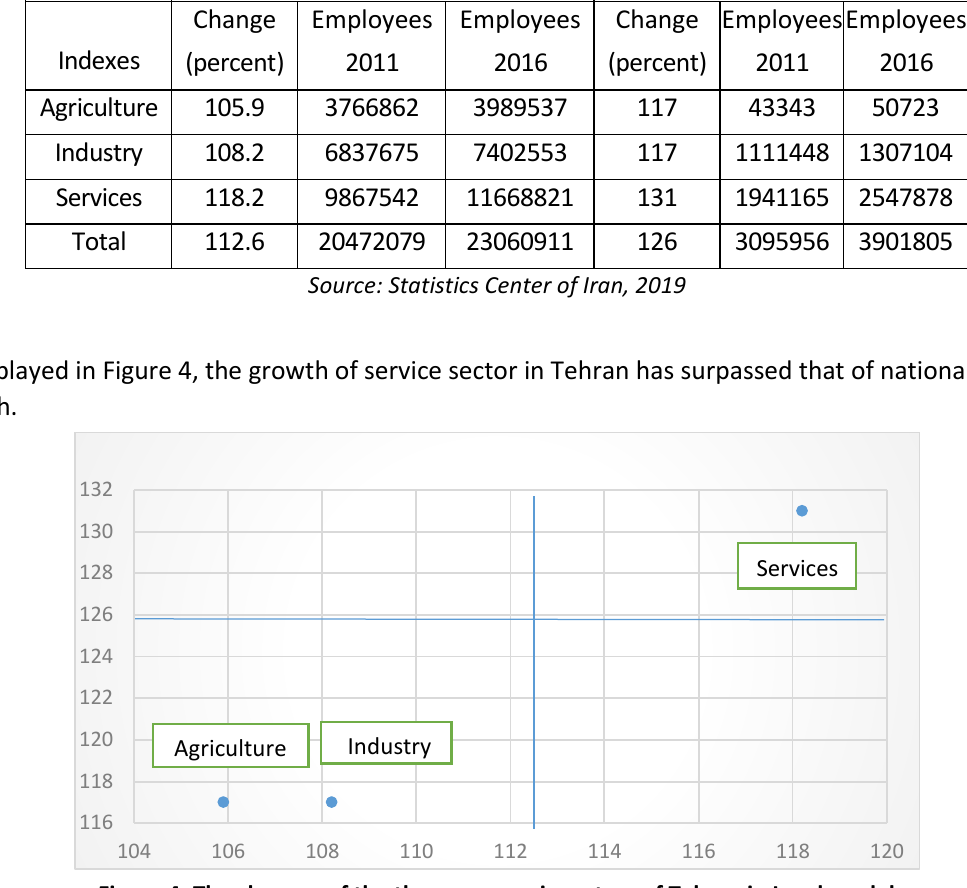
Figure 4: The changes of the three economic sectors of Tehran in Izard model Source: Authors,